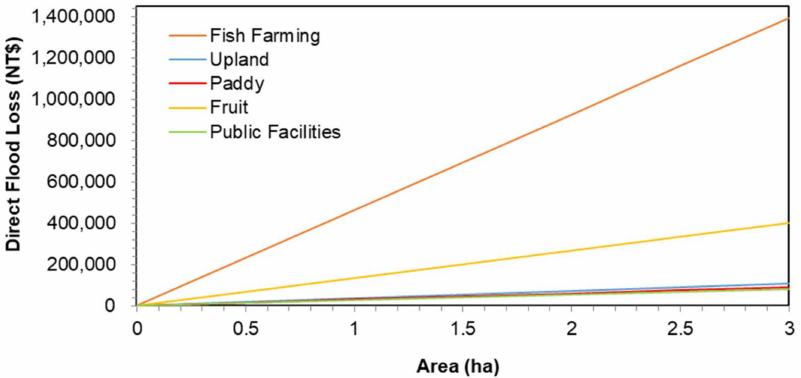
Figure 4. Relationship between direct loss of flooding and area for agriculture and public facilities for Tainan